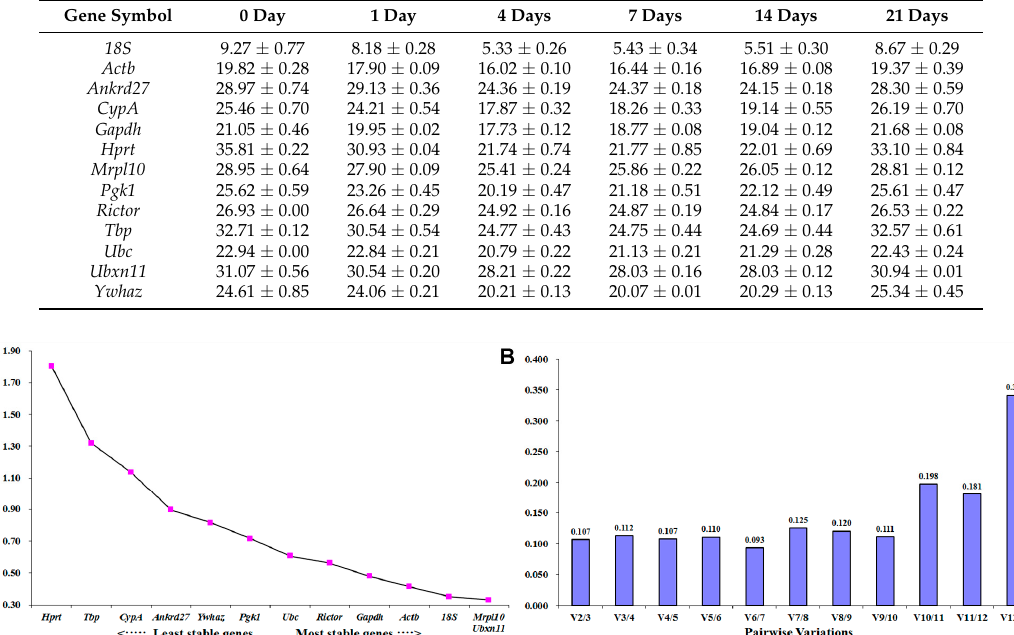
Table 1. Raw CT values of distal sciatic nerve samples at 0, 1, 4, 7, 14, and 21 days post sciatic nerve crush. (CT values were presented as means ± SEM).